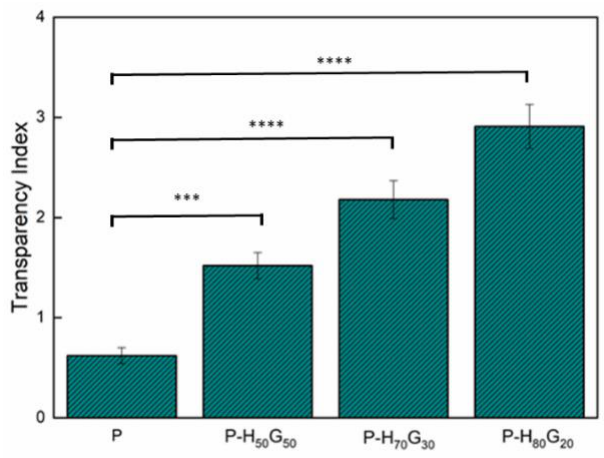
Figure 7. Transparency index of neat pectin and pectin composites. Statistically significant differences: *** p < 0.001 and **** p < 0.0001.